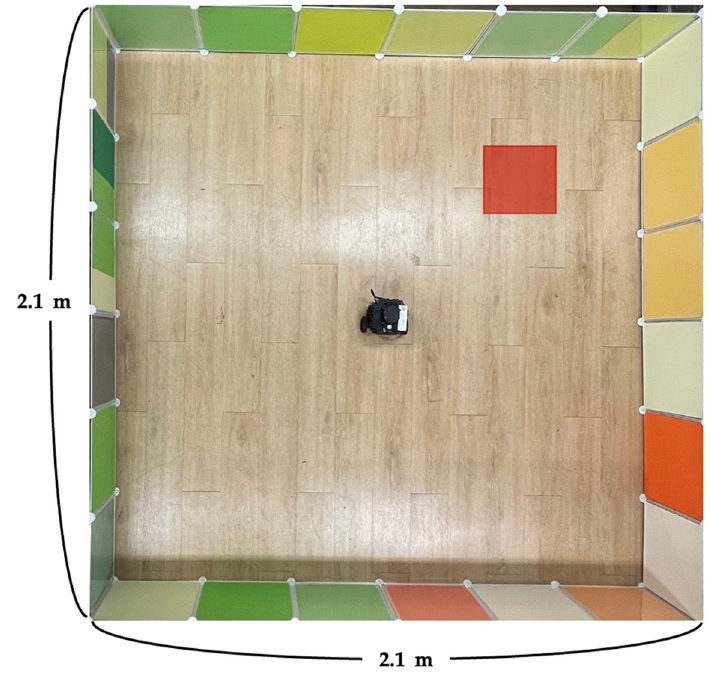
Figure 12. Real ‐ world environment used to verify the proposed method. Figure 12. Real-world environment used to verify the proposed